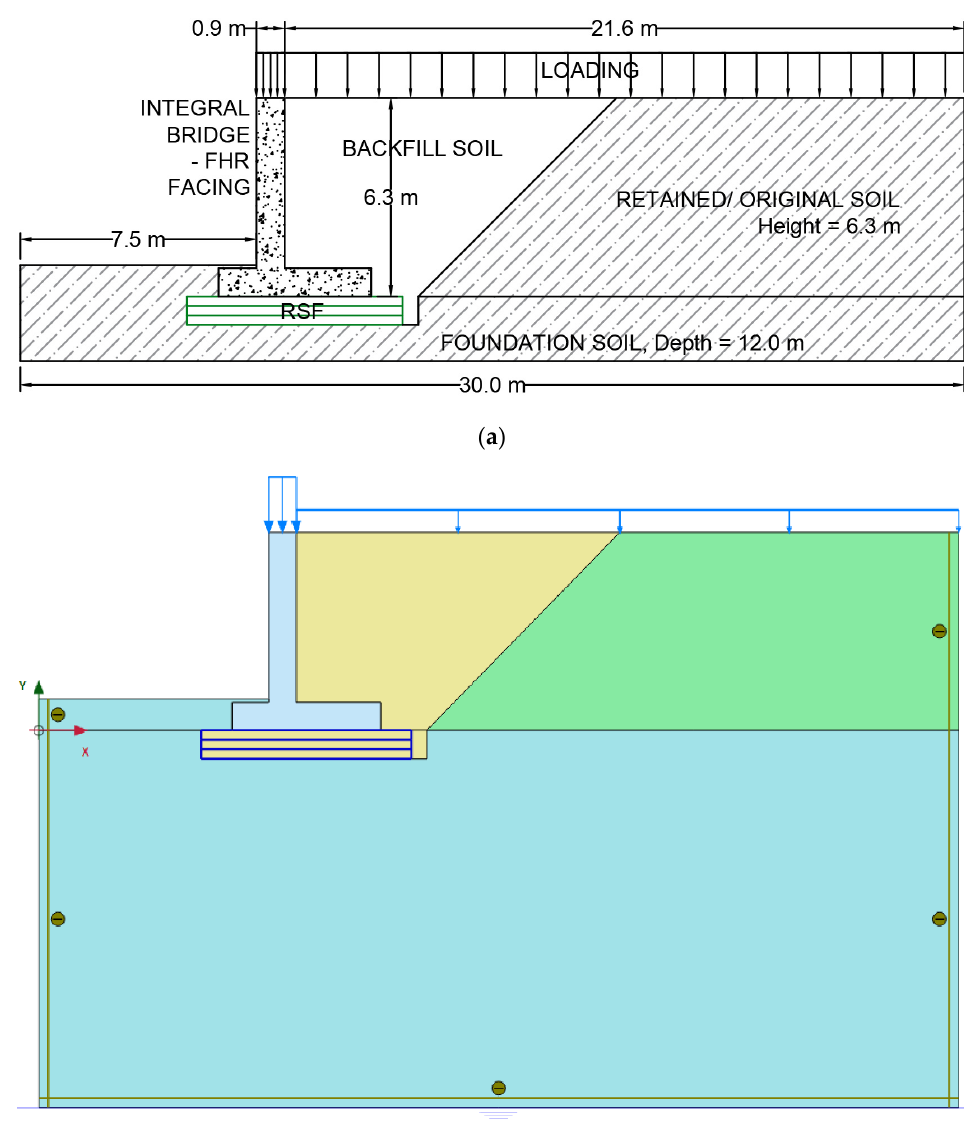
Figure 2. Design and Plaxis 2D Numerical Model for IB (Case 2). ( a ) Model Design for IB. ( b ) Plaxis 2D Numerical Model for IB.